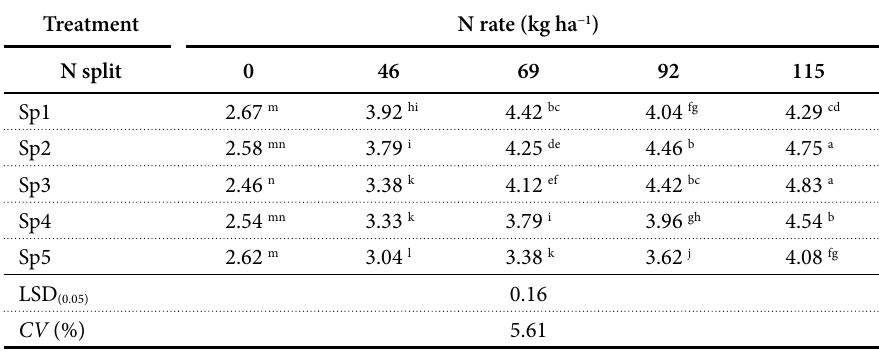
Tab. 4 Interaction effects of N rate and time of application on number of mother rhizomes per plant of Curcuma longa grown at Tepi, southwestern Ethiopia in